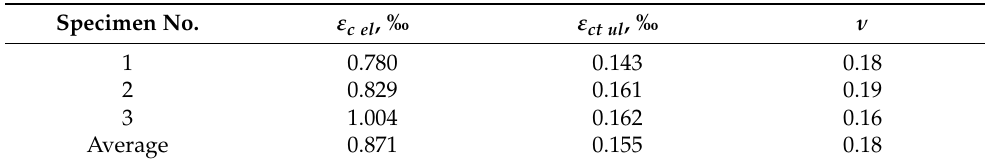
Table 7. Experimental values of maximum elastic strains, ultimate transverse strains, and Poisson’s ratios for HSC (following [6]).